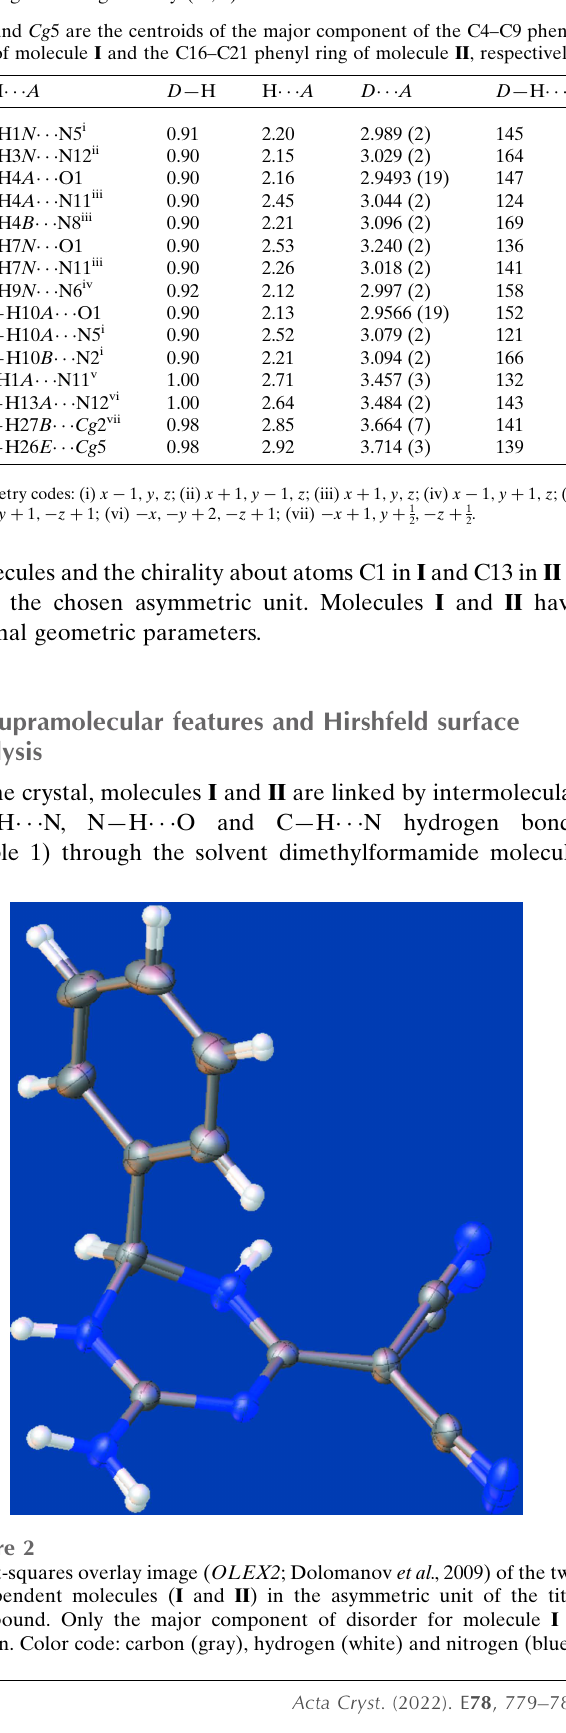
Figure 1 The molecular structure of the title compound. Displacement ellipsoids are drawn at the 50% probability level. Only the major disordered fragments are shown for clarity.